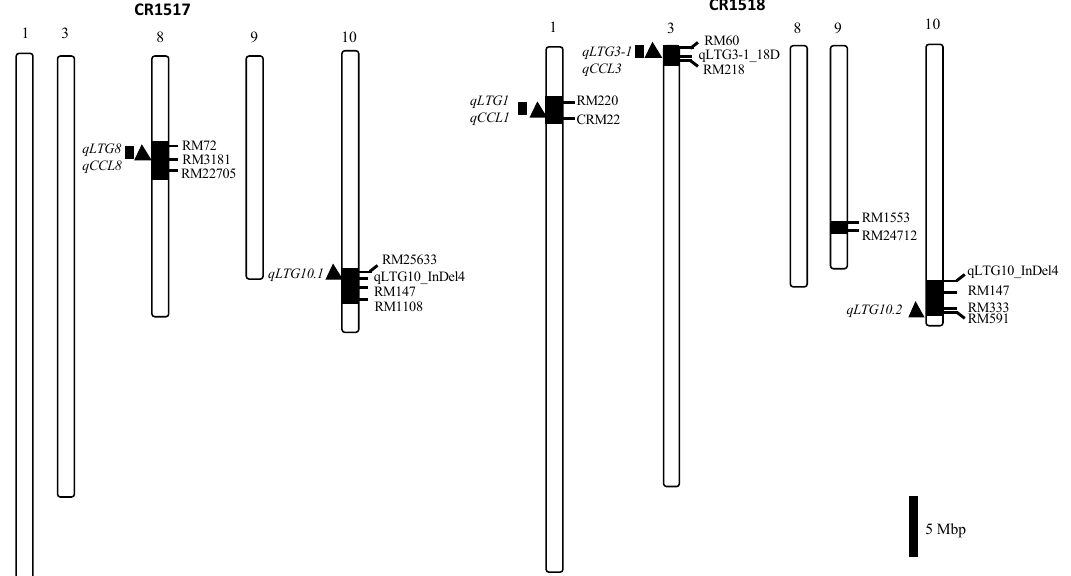
Figure 1. Graphical genotypes of two parental lines (CR1517 and CR1518) with the locations of five and three QTLs for low-temperature ( qLTG in filled triangle) and coleoptile length ( qCCL in filled box), respectively, on the left of the chromosomes. Black and white bars represent O. rufipogon and Hwaseong chromosome segments, respectively.